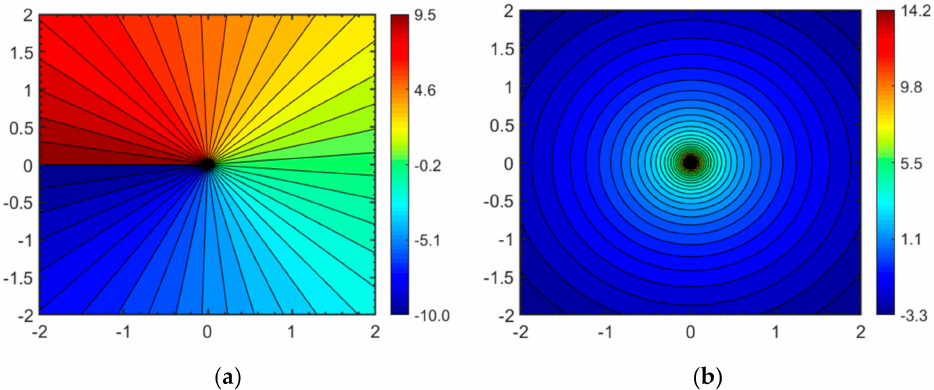
Figure 4. Vortex flow with ( a ) Potential lines ( Φ ) ( b ) Stream functions ( Ψ ). Strength of vortex ( Γ ) = 20 m 2 · s − 1 and z d = 0. Flow is anti-clockwise from low to high potentials; pressure gradient will be opposite to the potential